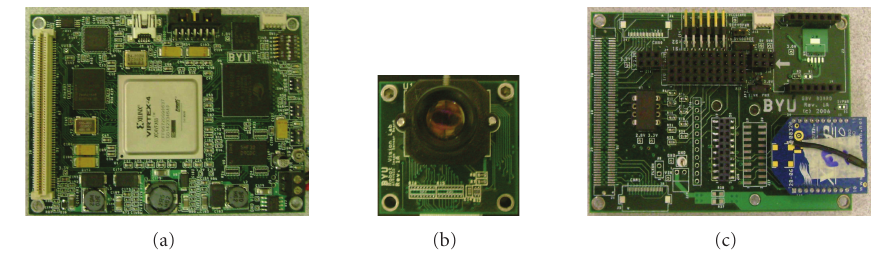
Figure 5: Hardware components: (a) Helios FPGA board, (b) CMOS imager, and (c) AVT daughter board.